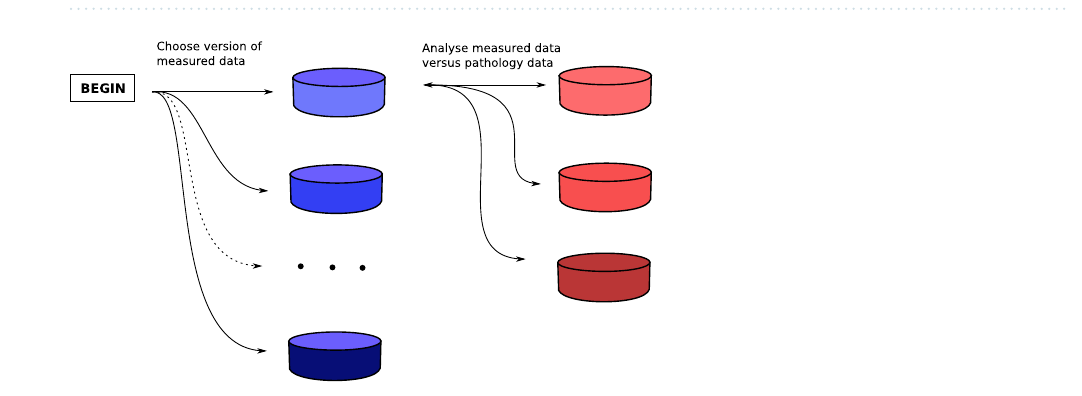
Figure 5. Diagram showing the correlation analysis between each combination of measured data and pathology